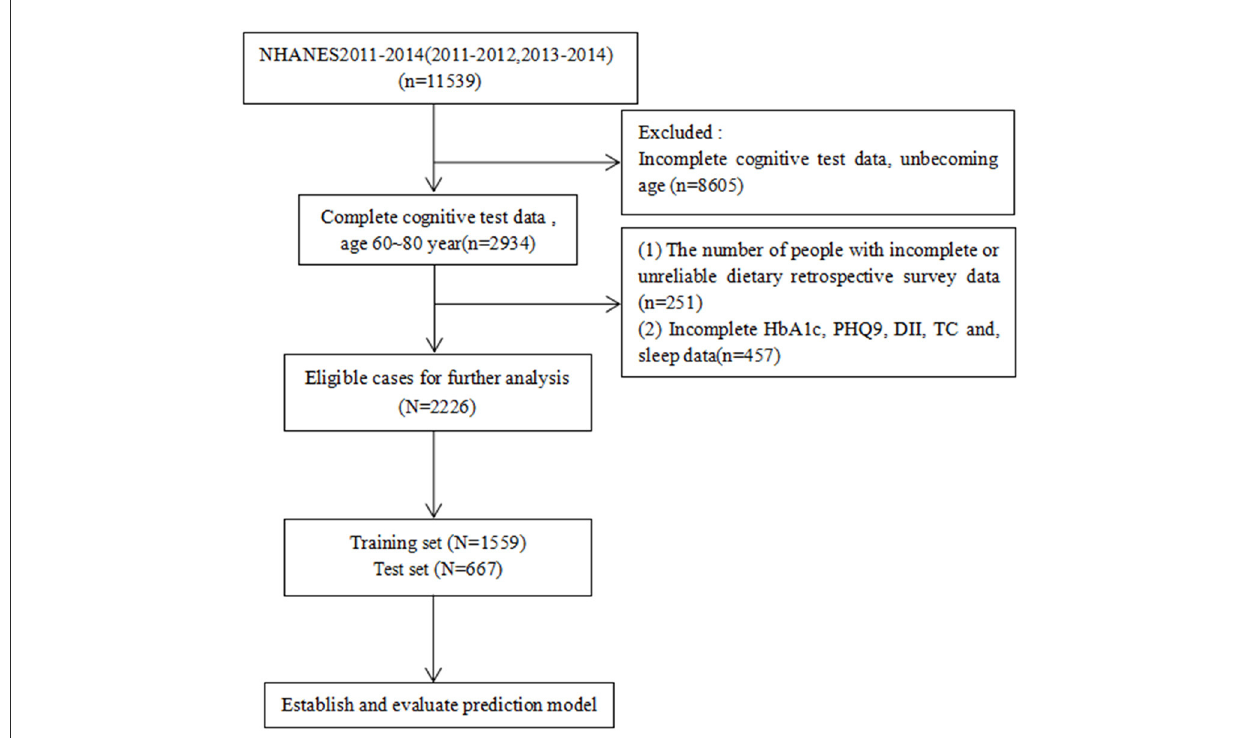
FIGURE1 Case inclusion process. DII, Dietary Inflammatory Index; HbA1c, glycated hemoglobin; PHQ9, Patient Health Questionnaire-9; sleep, how much sleep do you get; HDL, direct HDL-cholesterol level.